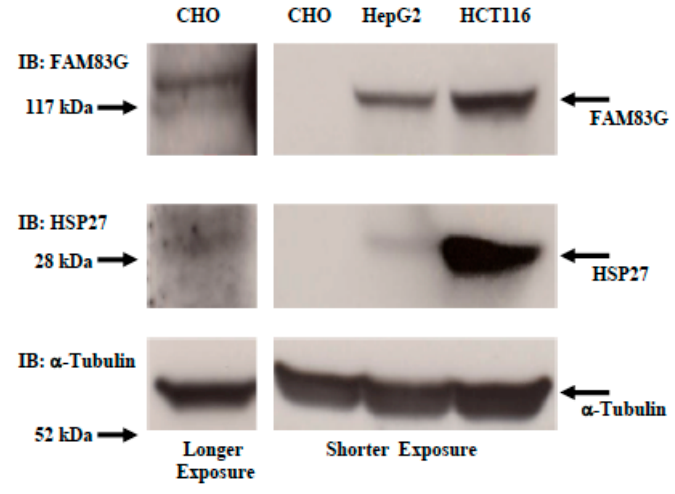
Figure 7. Comparison of endogenous FAM83G and HSP27 protein levels among CHO, HepG2, and HCT116 cells. Top panel: endogenous FAM83G protein. Second panel: endogenous HSP27 protein level. Bottom panel: -tubulin immunoblotting shows equivalent protein loading in each lane. Left lane: longer exposure to identify endogenous FAM83G and HSP27 proteins in CHO cells. Right panel: shorter exposure to identify endogenous FAM83G and HSP27 proteins in HepG2 and HCT116 cells. CHO; CHO cells.